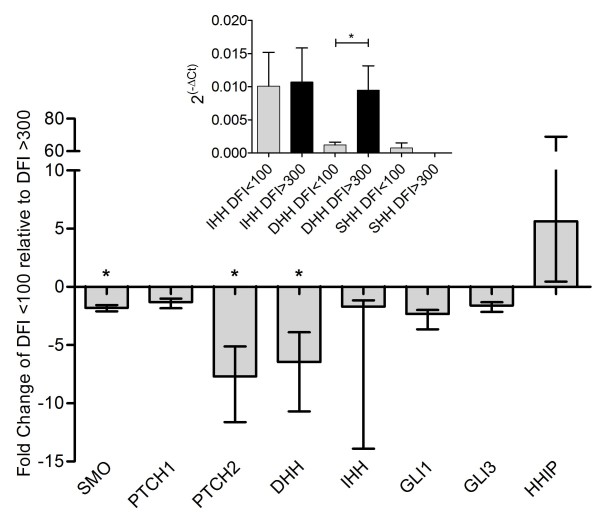
qRT-PCR analysis of the Hedgehog pathway. Fold change from qRT-PCR of eight genes in the hedgehog pathway. Genes were selected for analysis based upon significance of the hedgehog pathway in pathway analysis. Fold change calculated via the 2(-ΔΔCt) method (* = p < 0.05). Error bars represent standard deviation and are asymmetrical due to the exponential fold change calculations. Inset: expression represented as 2(-ΔCt) for hedgehog ligands, error bars represent standard error.